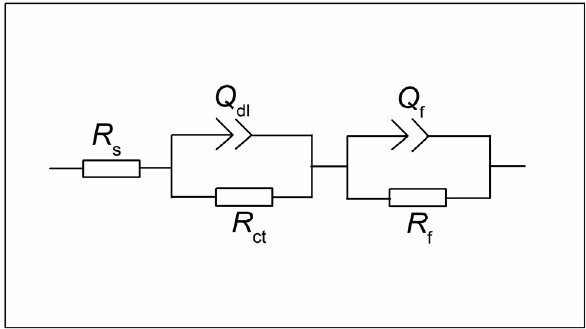
Figure 6. The equivalent circuit of the EIS for galena in NaCl solutions of different concentrations at pH 6.7.